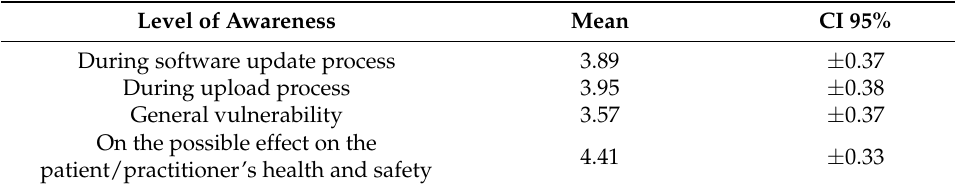
Table 12. Level of awareness in cyber-risk scenarios for SR. Level of Awareness Mean CI 95% During software update process During upload